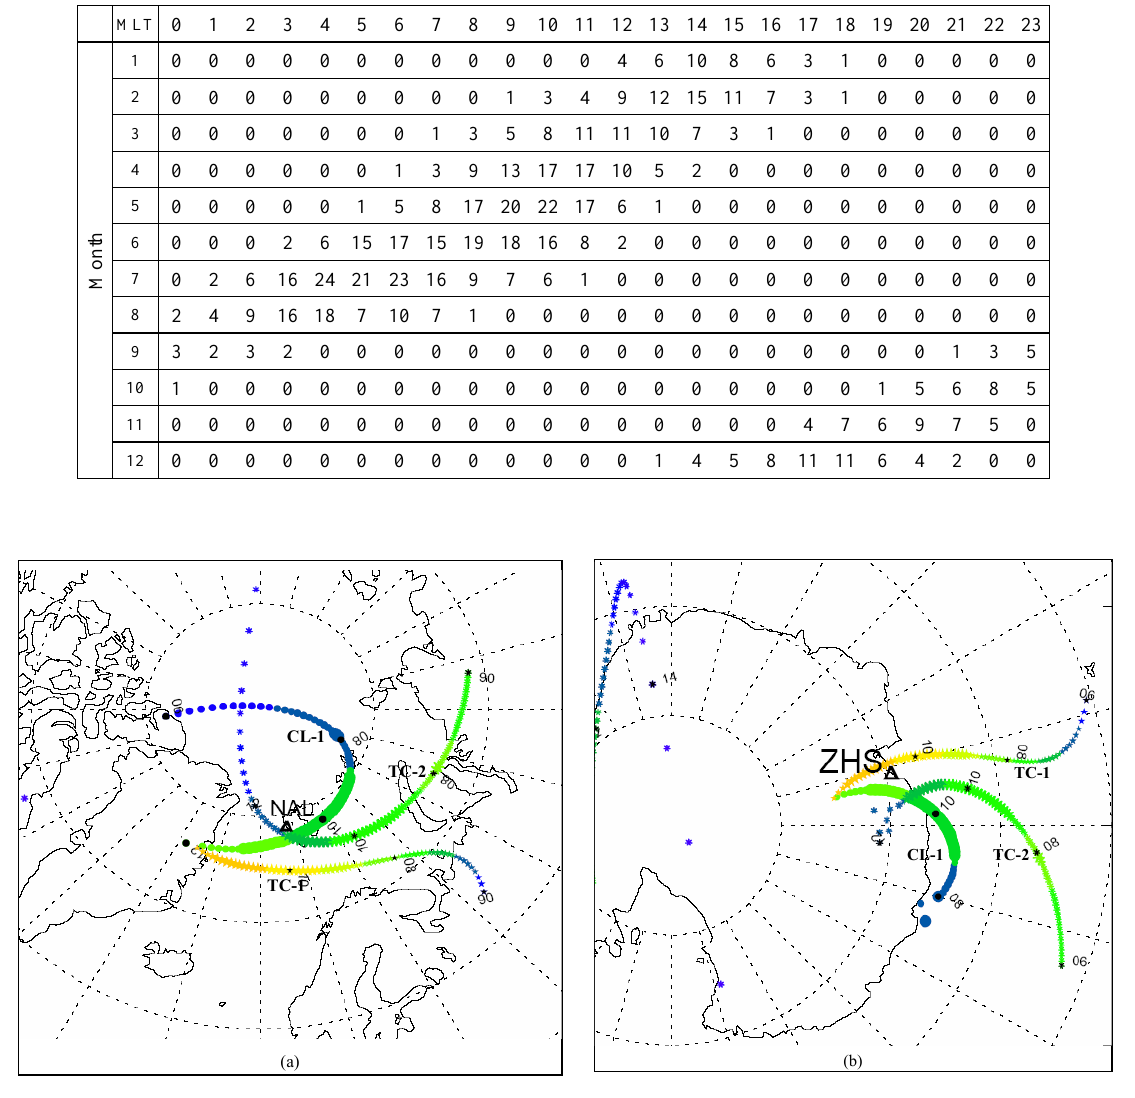
Fig. 8. Locations of the footprints of TC-1, TC-2 and CL-1 spacecraft in (a) the Northern Hemisphere and (b) the Southern Hemisphere, respectively, during 06:00–18:00UT on 25 February